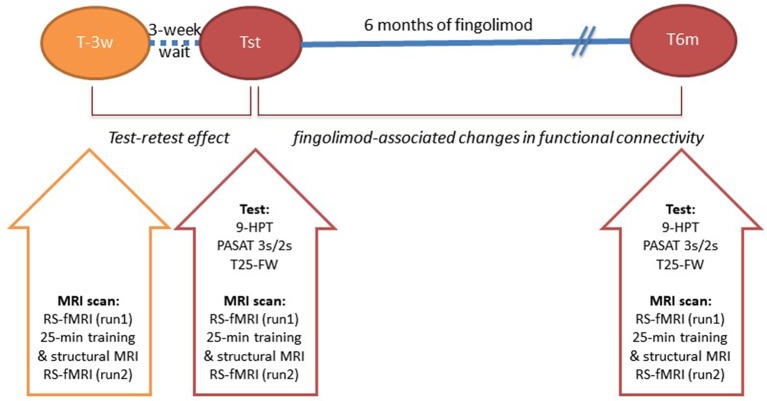
Study Design: patients were assessed in three different sessions with respect to the fingolimod treatment: 3 weeks before initiation (T-3w), a day or two before fingolimod therapy initiation (Tst) and at 6 months of fingolimod treatment (T6m). Abbreviations: 9-Hole Peg Test (9HPT); Paced Auditory Serial Addition Test (PASAT) at 3 and seconds; 25-Feet Walk Test (25-FWT); resting-state functional MRI (RS-fMRI).